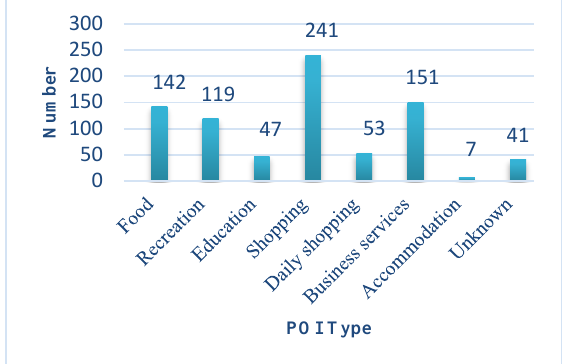
Table 8. POI and land use in place ontology.